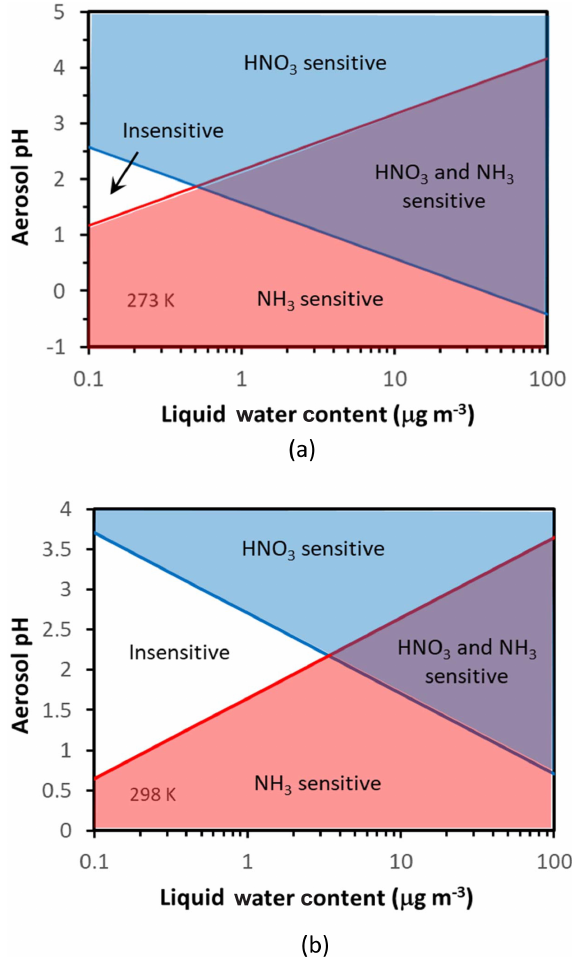
Figure 3. Chemical domains of aerosol response to ammonia and nitrate emissions. Shown are results for 273K (a) and 298K (b) . Note that there exists a fairly expansive region of acidity and liquid water content (especially for warmer temperatures) where aerosol is relatively insensitive to ammonia and nitrate emissions; here only nonvolatiles (sulfate, NVCs) can have an appreciable impact on aerosol mass. Also important is the role of aerosol water in help- ing define the chemical regime of aerosol sensitivity to